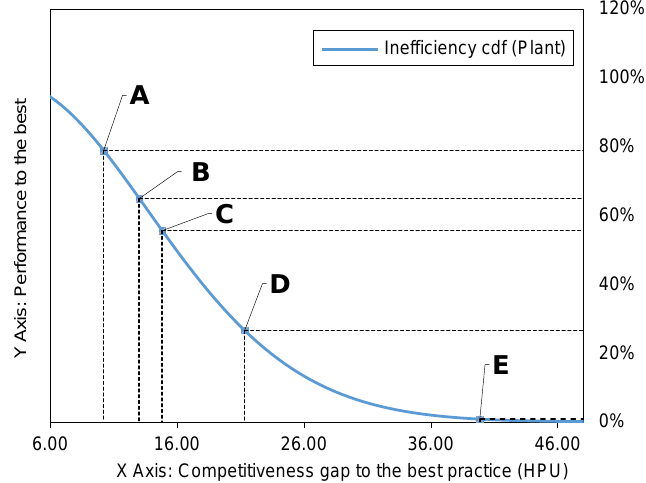
X Axis: Competitiveness gap to the best practice Figure 6. Assessment for plant.